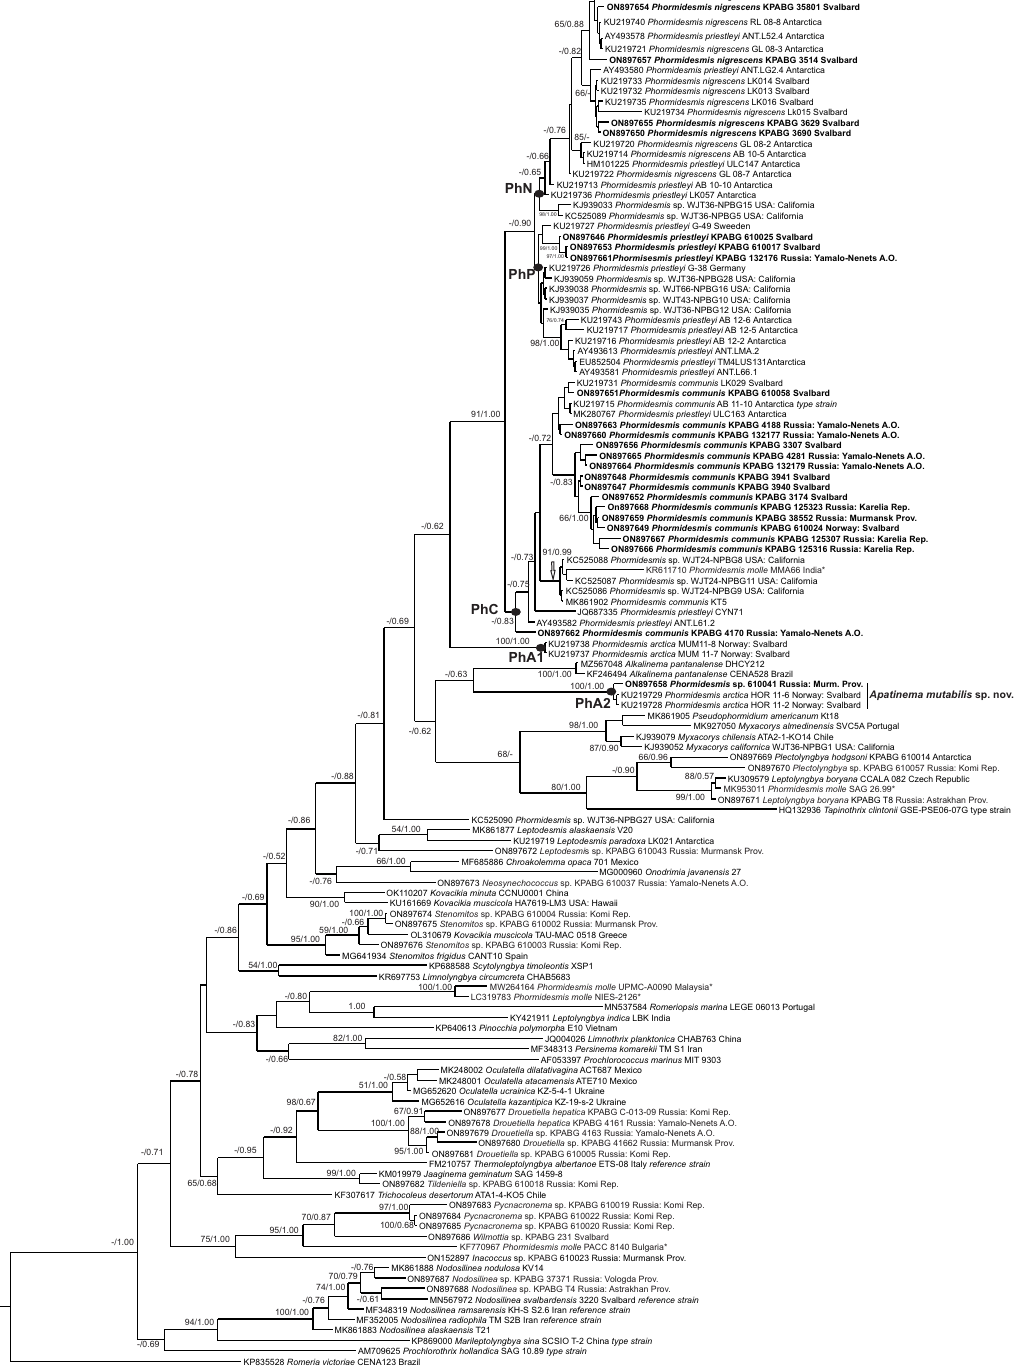
Figure 2. Phylogram obtained under the Bayesian approach for 137 accessions of Leptolyngby- aceae and related taxa based on 16S rRNA gene. Bootstrap support values from maximum like- lihood and Bayesian posterior probabilities more than 50% (0.50) are indicated. The strains se- quenced in the current study are in bold, accessions of Phormidesmis molle are marked by asterisk. PhA1— Phormidesmis arctica clade 1, PhA2— Phormidesmis arctica clade 2, PhC— Phormidesmis commu- nis , PhN— Phormidesmis nigrescens , PhP— Phormidesmis priestleyi